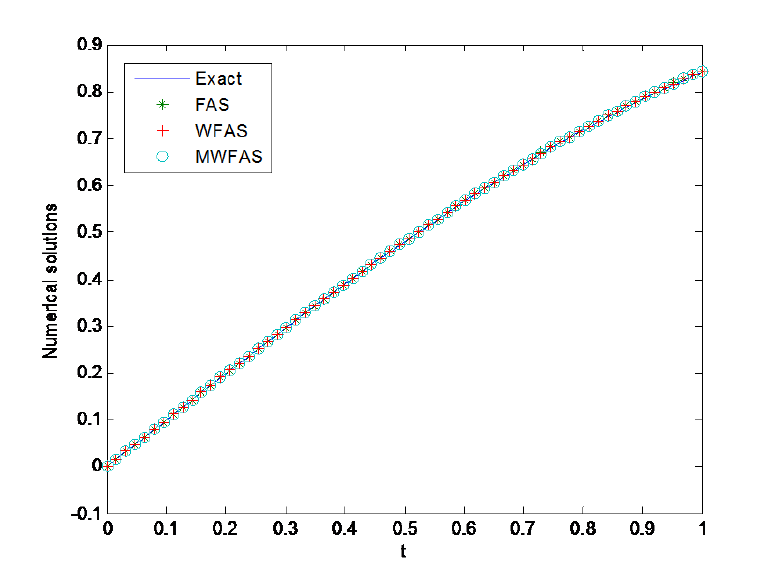
Fig. 2 Comparison of numerical solutions with exact solution of test problem 5.2, for N